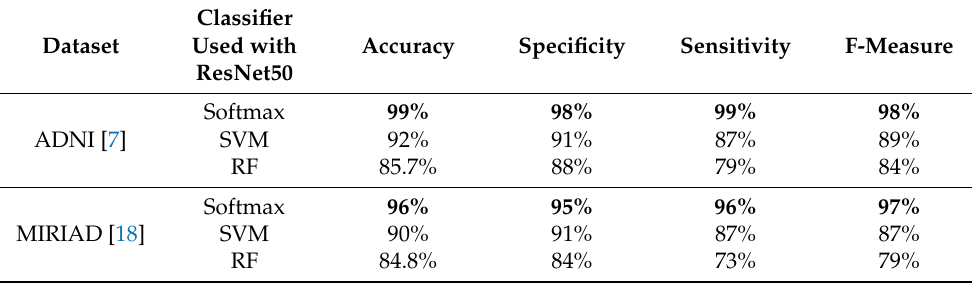
Table 3. Performance of the three classifiers in the proposed